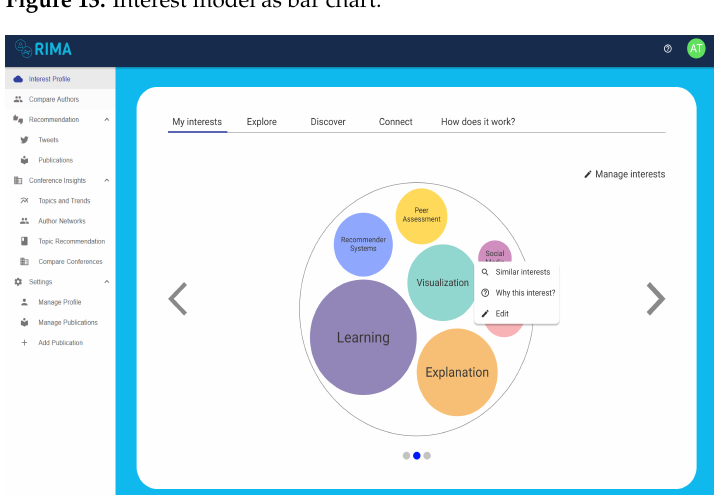
Figure 13. Interest model as bar chart.